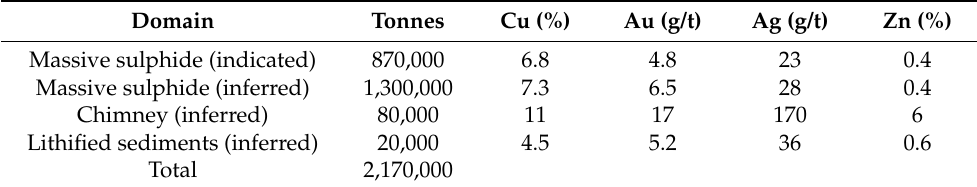
Figure 2. The location of Solwara I in the Bismarck Sea. Table 4. Indicated and inferred mineral resources for Solwara I [46,51].